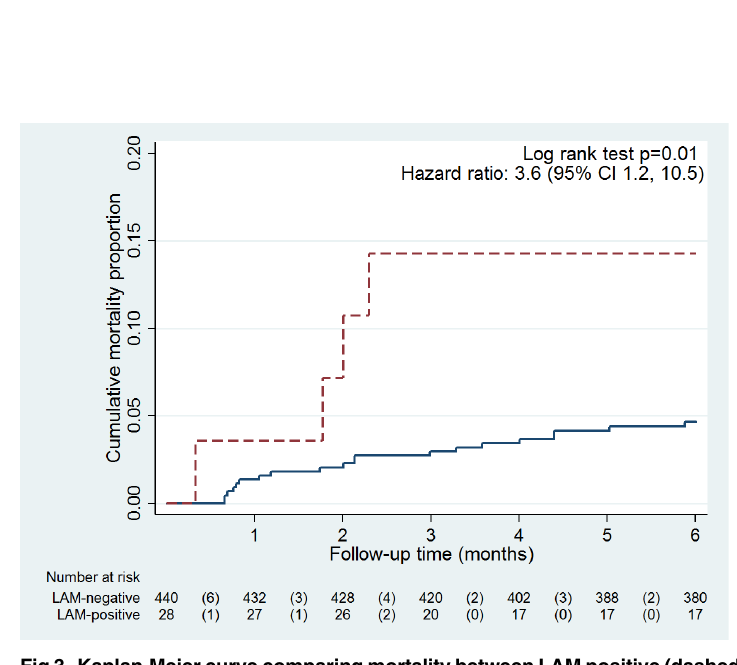
Fig 3. Kaplan-Meier curve comparing mortality between LAM positive (dashed line) and LAM negative (solid line) participants using grade 1 cut-off. Y-axis range for cumulative mortality is 0 to